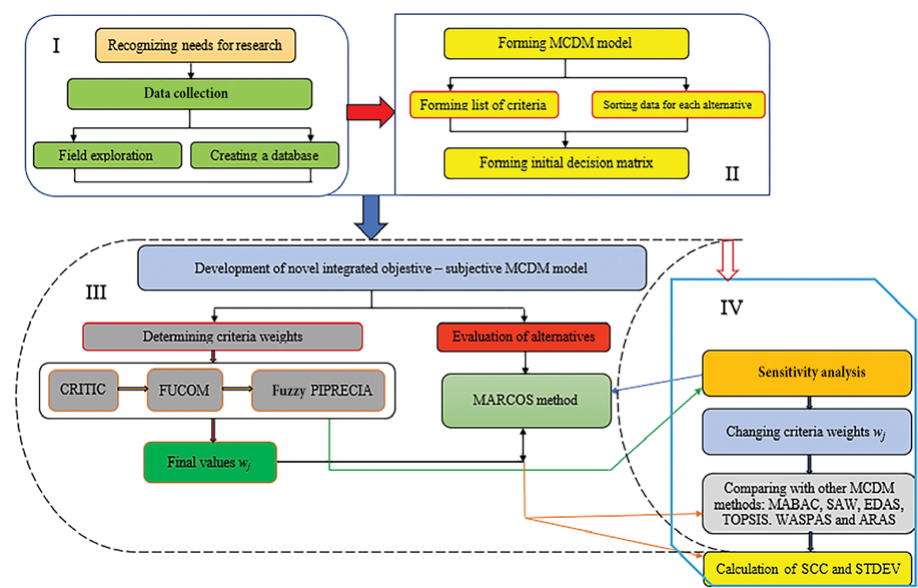
Figure 1. Applied methodology for the evaluation of two-lane road sections in terms of traffic